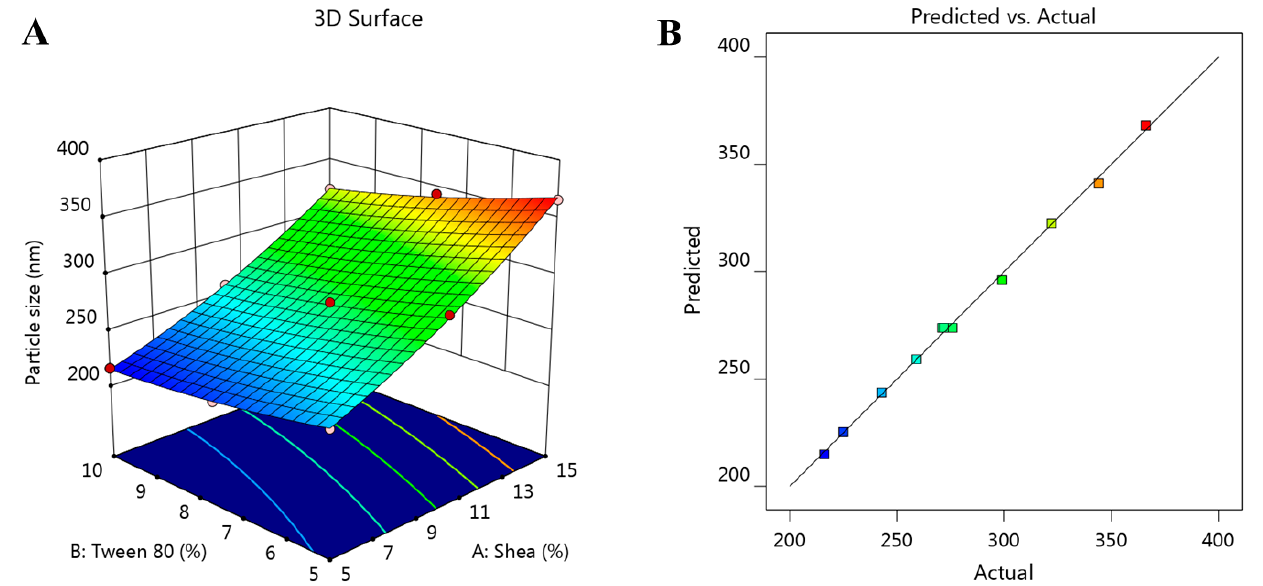
Figure 1. ( A ) The 3D-response surface graph showing the influence of independent factors, shea and Tween 80 concentrations, on the investigated particle size (R 1 ), and ( B ) linear correlation plot between predicted and actual values validating the effect of various independent factors on particle size response (R 1 ).